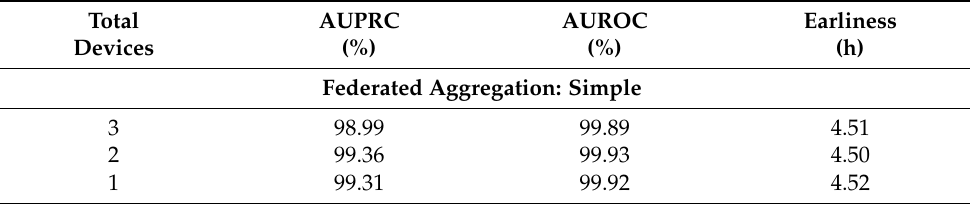
Table 15. Evaluation results using multi-modal (both clinical-text and non-text ) input features in a federated learning setting using different number of Jetson Nano devices.